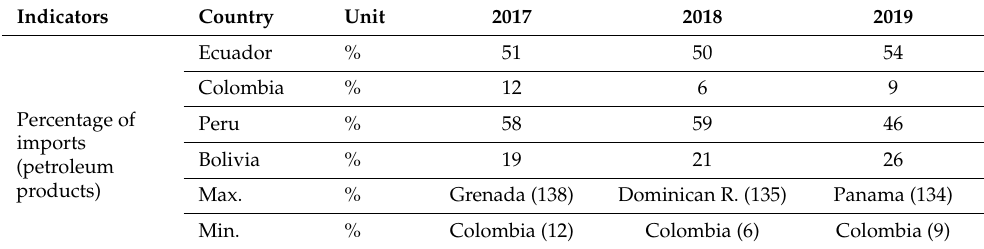
Table 3. The key indicators of the energy security dimension in the members of the Andean Commu- nity (in absolute